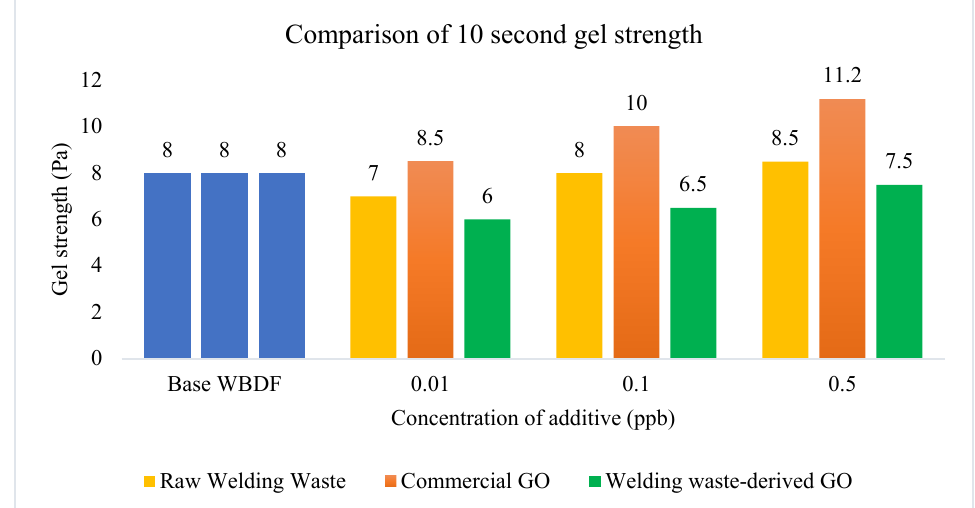
Figure 8. 10 s GS comparison of WBDF using different additives.